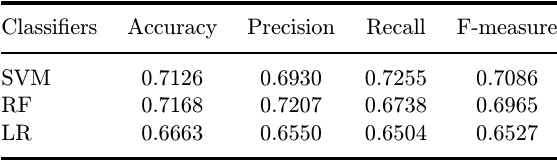
Table 3. Classi¯cation performance based on features in